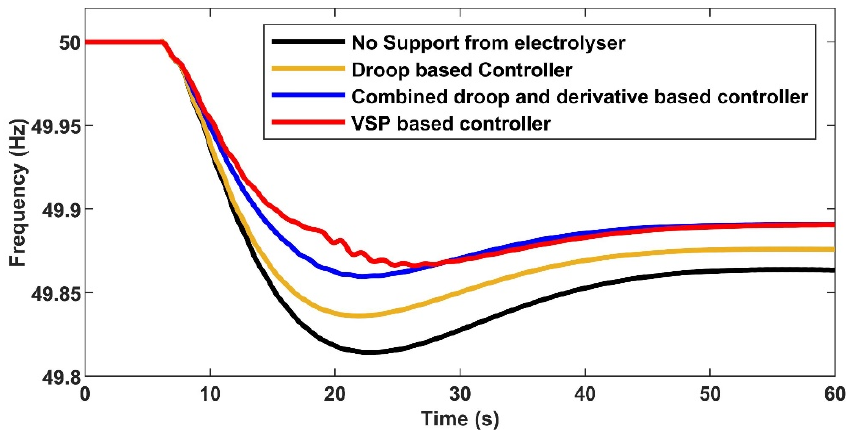
Figure 9. Shape of the system frequency response due to the action of FAPR on the PEM